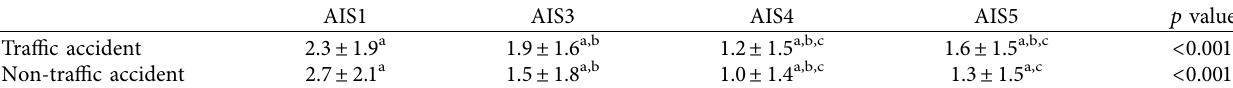
Table 3: Te correlation between trafc accident and injury sites.